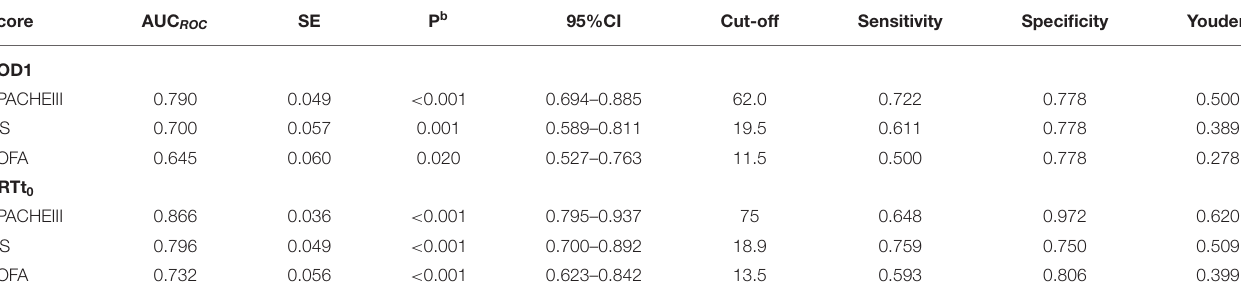
TABLE 4 | ROC curve measures.